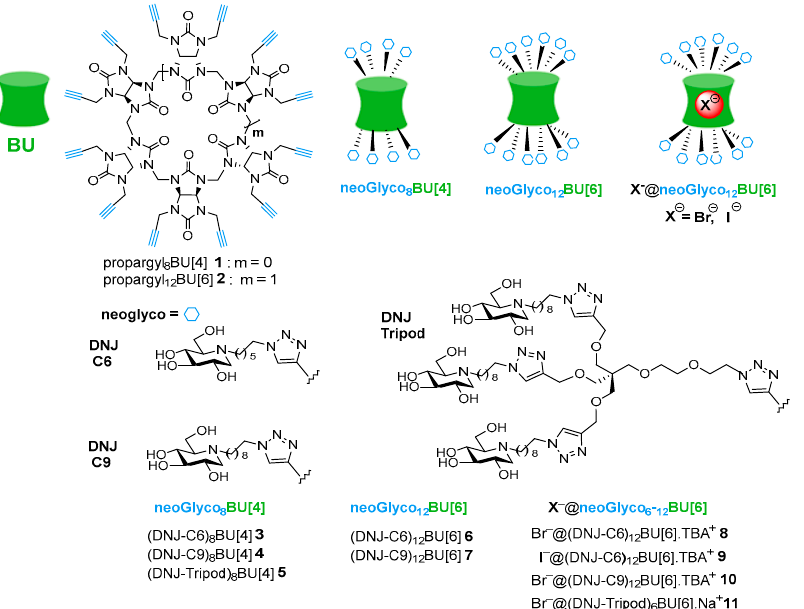
Figure 1. Structures of propargyl 8 BU[4] 1 , propargyl 12 BU[6] 2 , neoglycobambusurils BU[4] 3 – 5 and BU[6] 6 , 7 and Br − @BU[6].TBA + 8 , 10 – 11 and I - @BU[6].TBA + 9 bearing DNJ ligands studied in this